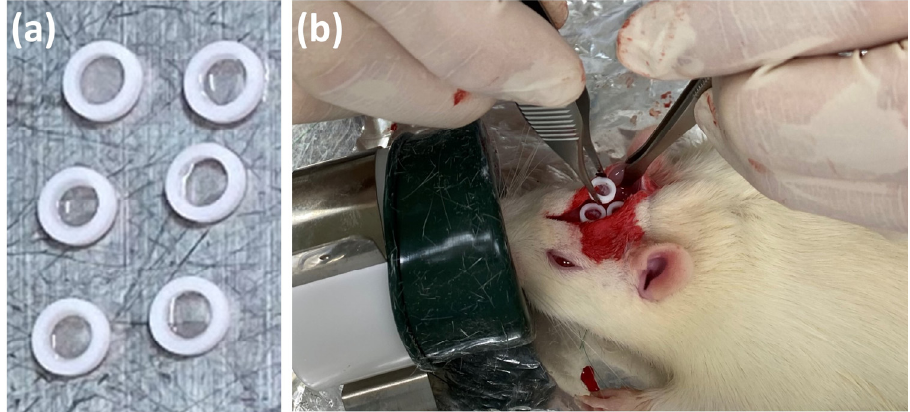
Figure 5. ( a ) Prepared SG II*BMP (+) = x-tHyA + nHAp + BMP samples gelled in Teflon rings;